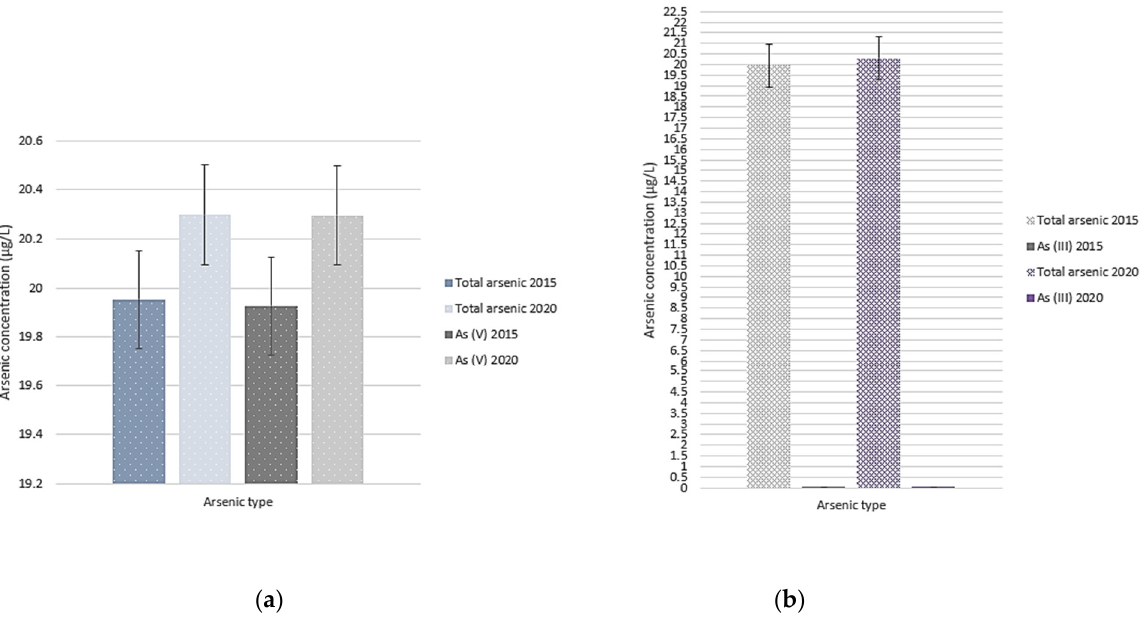
Figure 6. Comparison of total arsenic in groundwater of the study area with ( a ) As (V) and ( b ) As